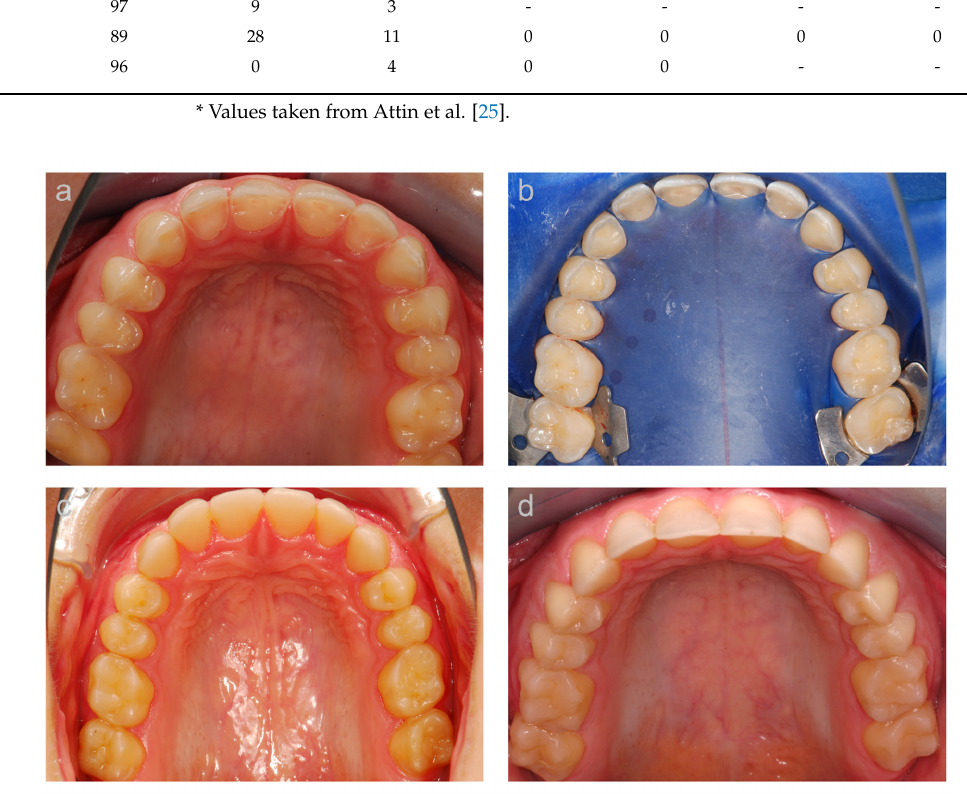
Figure 3. Example of a case (occlusal view of upper jaw) of the second cohort. ( a ) Baseline situation; ( b ) clinical situation at the reconstructive appointment before treatment, and ( c ) after the composite vertical bite reconstruction; ( d ) clinical situation at the 5-year follow-up.